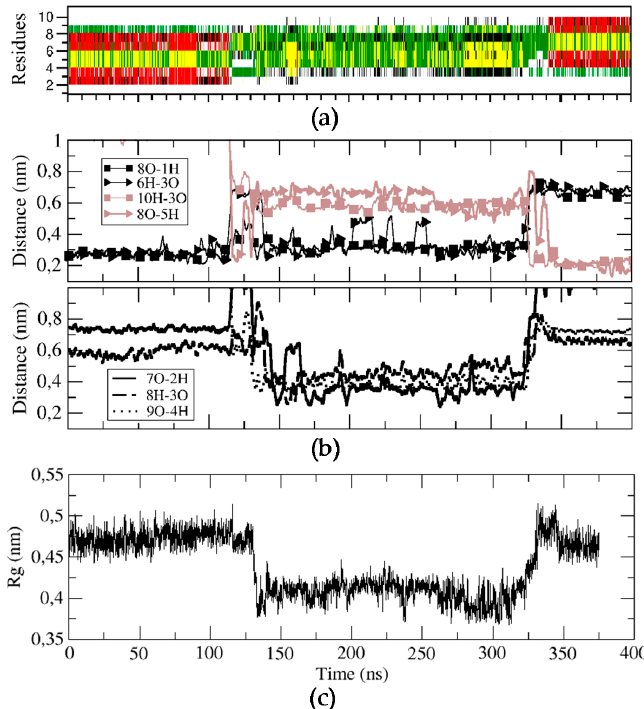
Figure 4. Structural characterization of the BPC198 simulation. ( a ) DSSP plot, ( b ) time evolution of the relevant hydrogen bond distances and ( c ) radius of gyration (nm) of the backbone structure along the trajectory.